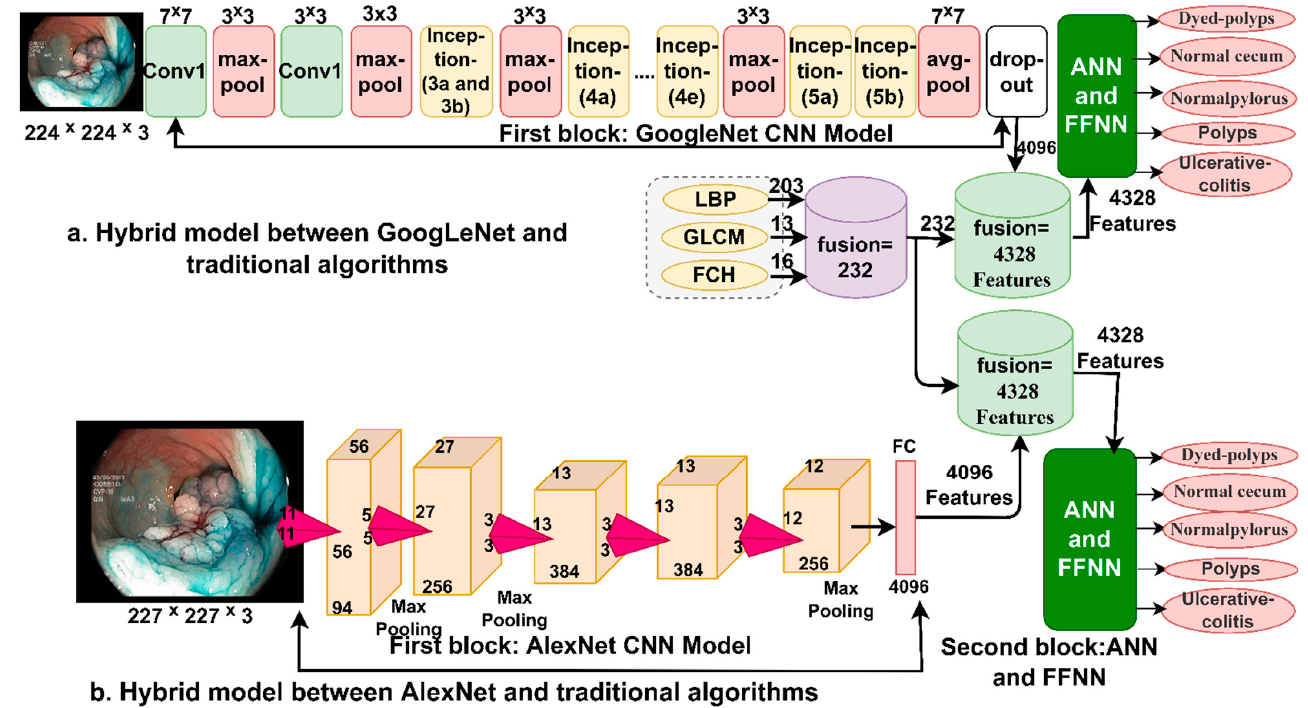
Figure 9. The general structure of feature fusion between CNN models and LBP, GLCM, and FCH algorithms.